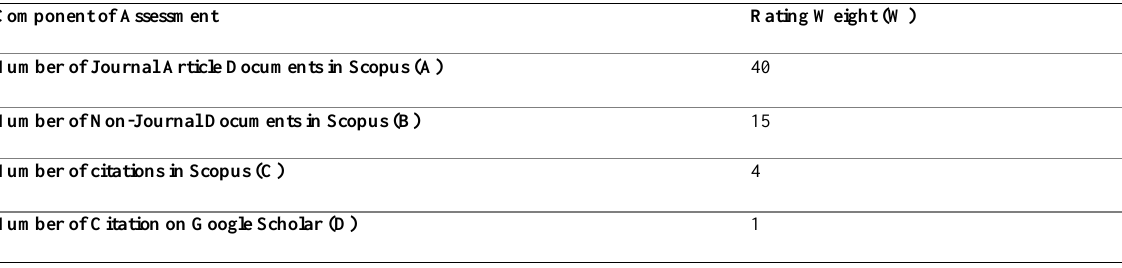
Table 2 : SINTA Score Component and Formula version